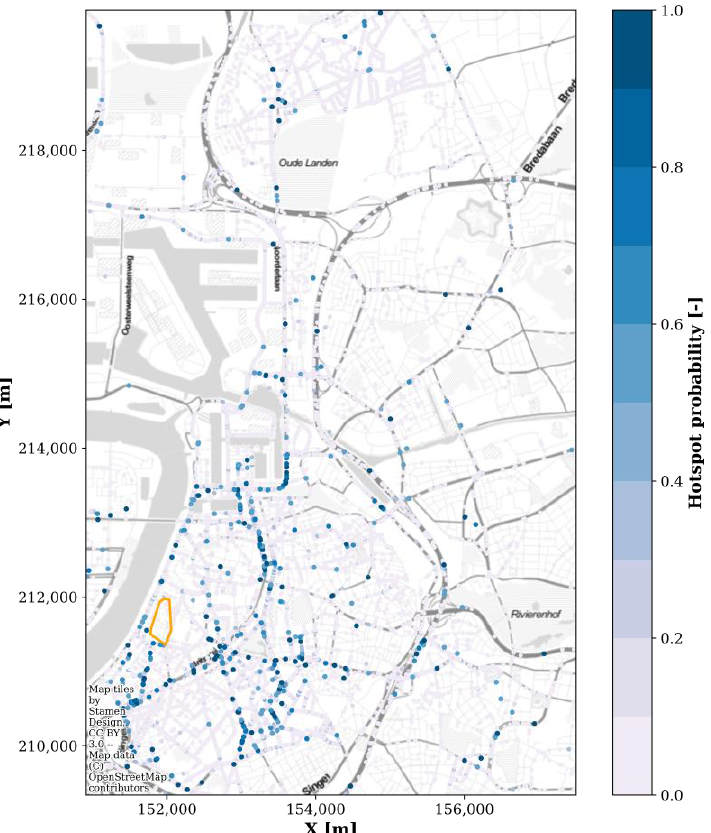
Figure 17. Probability of hotspots in the area covered by 95% of the mobile RF sensor samples. The orange delineated area is the area covered by the fixed RF sensor network (coordinate system: Belgian Lambert 1972).